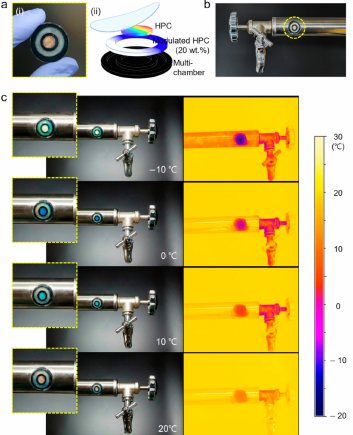
Figure 5. Device concept and application of the integrated HPC colorimetric temperature sensory system. ( a ( i )) photograph showing the integrated sensor and ( a ( ii )) schematic of the architecture. ( b ) Photograph showing the sensor mounted onto metal water pipe. ( c ) Photograph showing the color response of the sensor and thermal camera image showing the temperature of the structure.